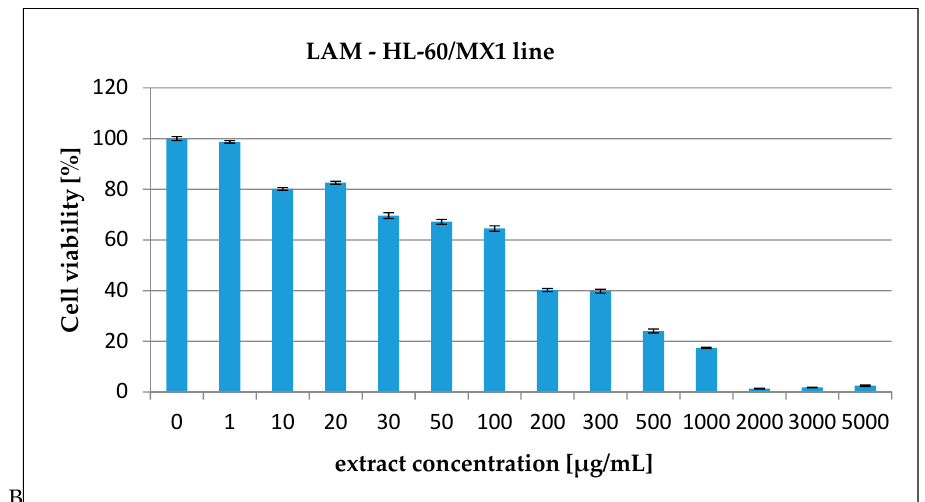
Figure 4. The valuation of the HL-60 / MX1 cell line viability exposed to 24 h of increasing concentrations of: ( A )—LAEN extract and ( B )—LAM extract.